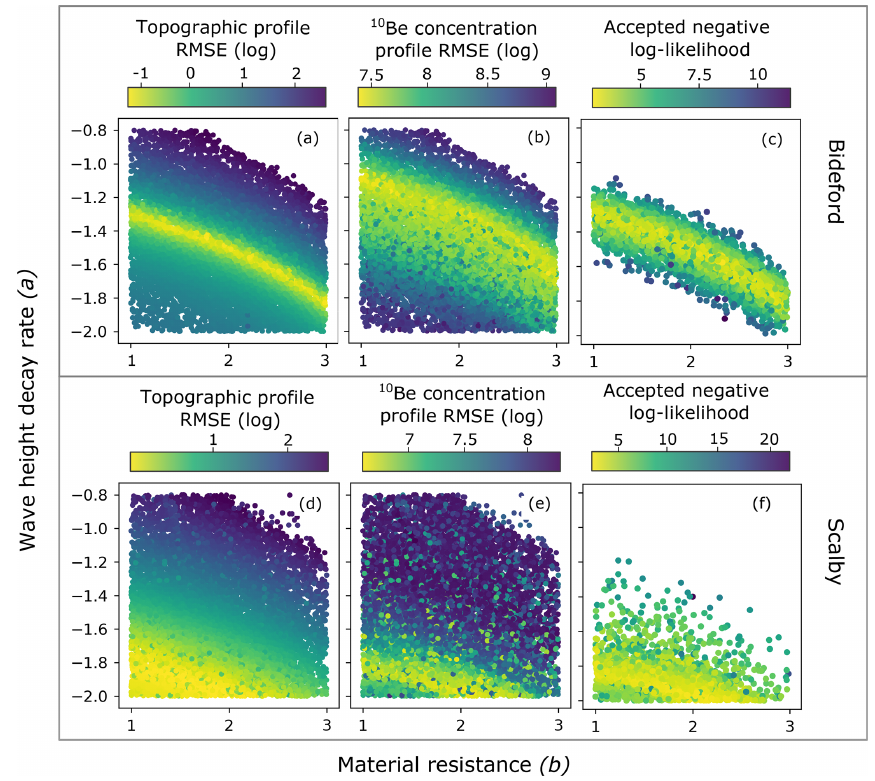
Figure 10. Objective function results for the material resistance ( b ) wave height decay rate ( a ) parameters constructed from 50%–50% weighted MCMC analysis results for the Bideford site and Scalby site. The topographic profile RMSE (a, d) and 10 Be concentration profile RMSE (b, e) objective function spaces are constructed from all 10000 samples visited in the MCMC analysis. The combined likelihood objective function space (c, f) is constructed just using the accepted samples from the MCMC analysis. Dark blue corresponds to the worst samples that have the highest RMSE and negative log-likelihood scores, while bright yellow corresponds to the best samples that have the lowest RMSE and negative log-likelihood